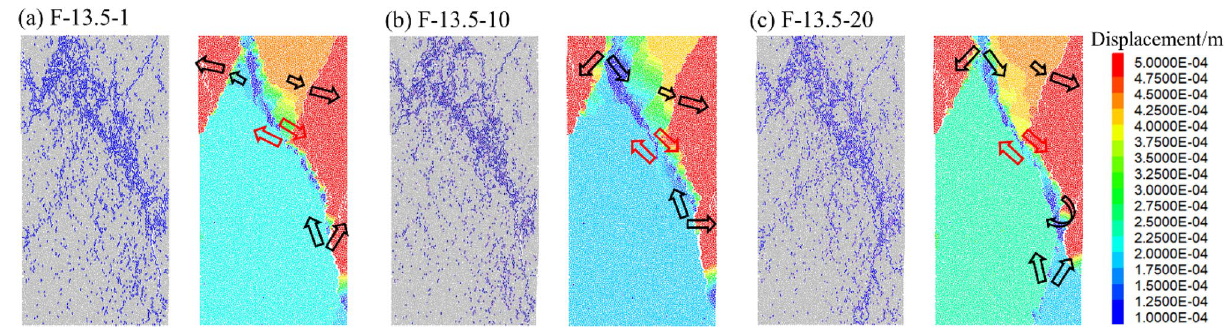
Figure 14. Crack distribution and displacement vector field of rock specimens ( A = 13.5